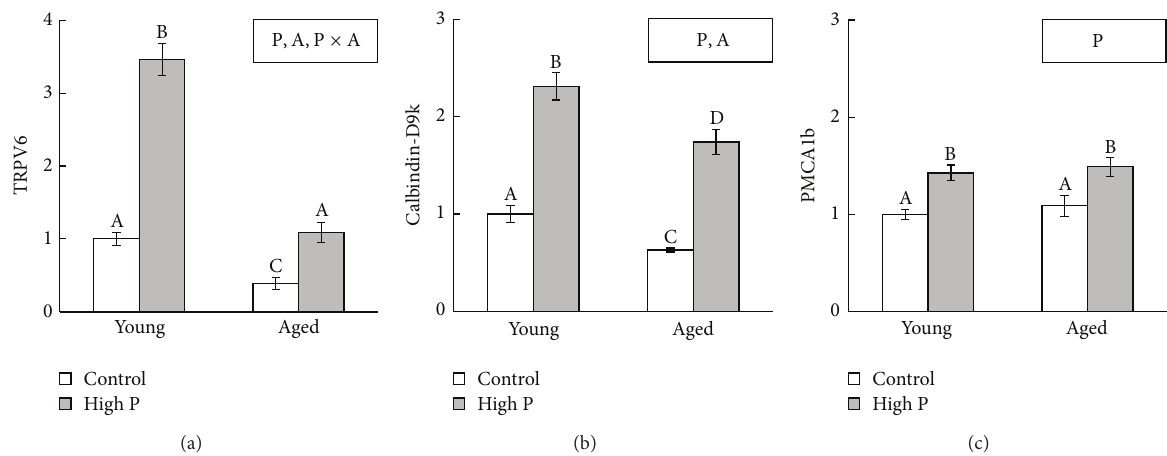
Figure 2: Ca absorption-related gene expression in the duodenum. (a) TRPV6; (b) calbindin-D9k; (c) PMCA1b. The data indicate the mean ± SEM of 6 mice. A , B , C , D The different letters denote significant differences ( 𝑃 < 0.05 ). Significant effect ( 𝑃 < 0.05 ): P = effect of high P diet; A = effect of age; P × A = effect of interaction. The value of young mice fed a control diet is considered to be